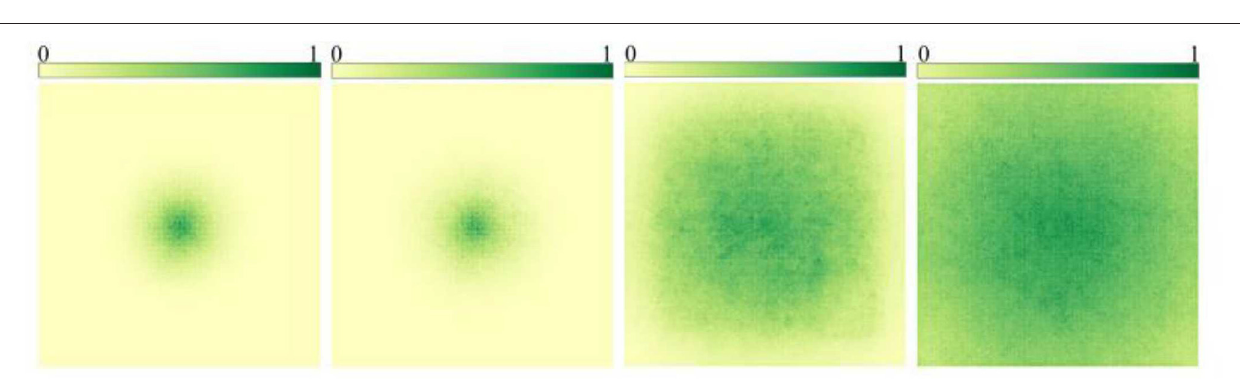
stronger than stacking small convolutional kernels, shown in Figure 3